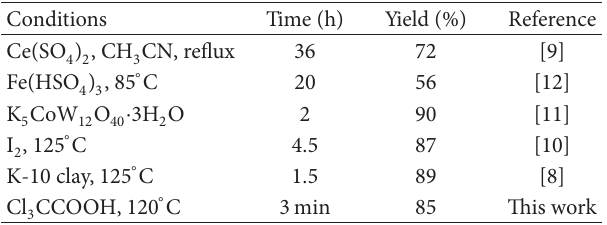
T 2: Comparison of efficiency of various catalysts in the synthesis of 1-amidoalkyl-2-naphthols a